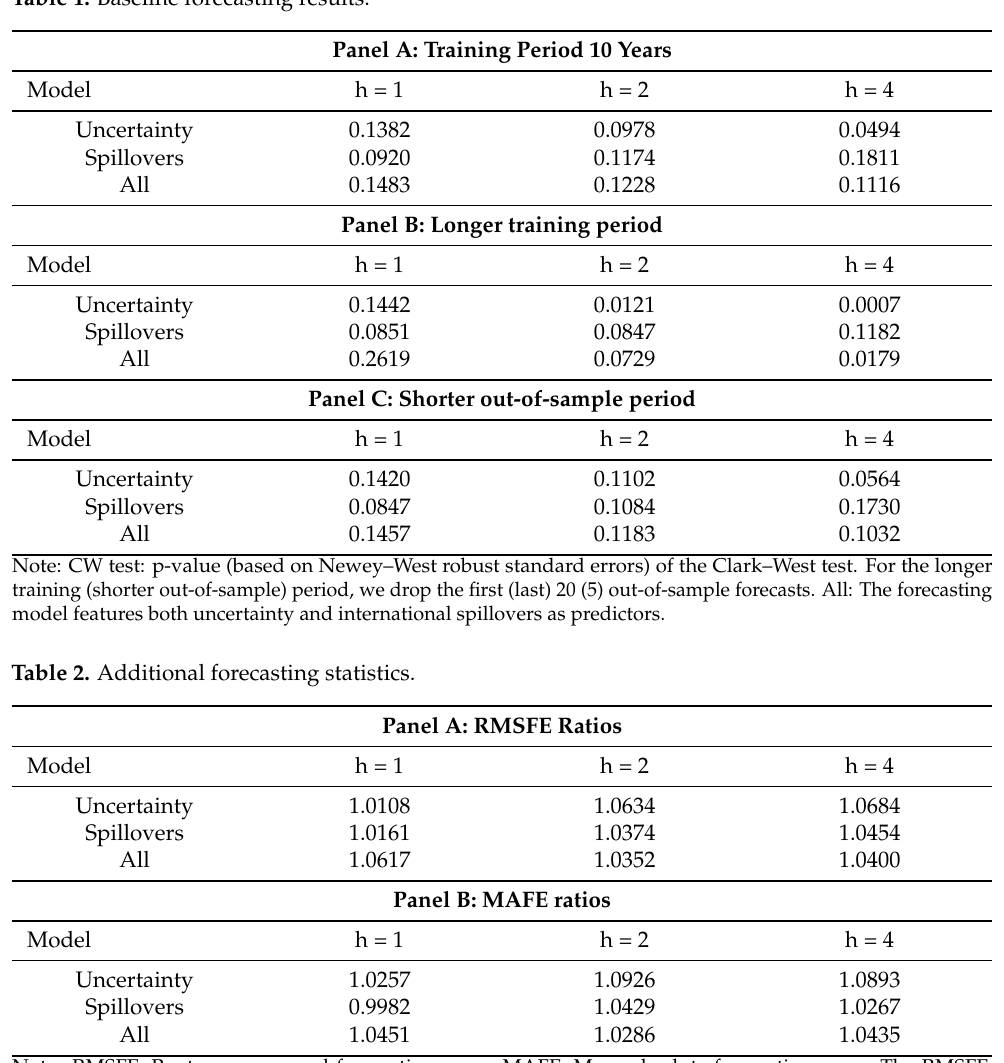
Table 1. Baseline forecasting results.